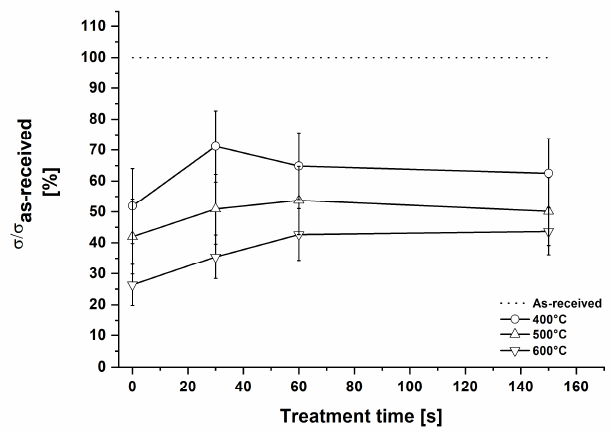
Figure 1. Percentage of strength retention for basalt fibres after NaOH treatment as a function of pre-treatment temperature.